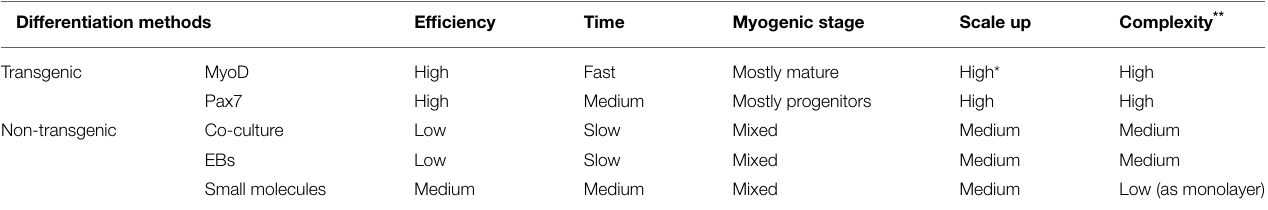
TABLE 1 | Methods for the myogenic differentiation of